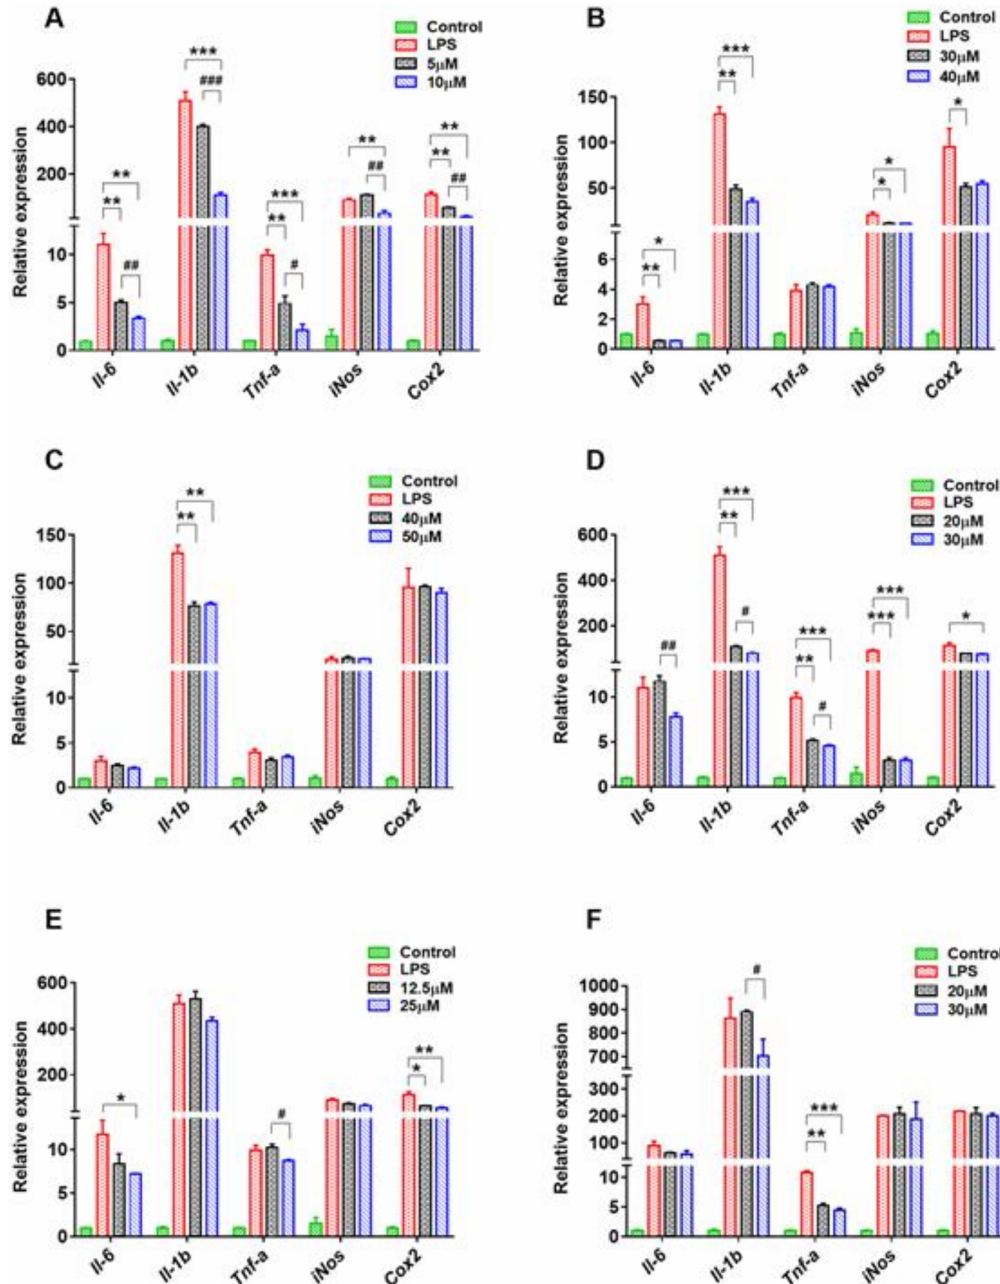
Figure 4. E ff ect of compounds 1 , 3 , 4 , and 6 – 8 ( A – F ) on the messenger RNA (mRNA) levels of interleukin-6 (IL-6), IL-1 β , tumor necrosis factor α (TNF- α ), inducible nitric oxide synthase (iNOS), and cyclooxygenase 2 (COX-2) in RAW264.7 cells stimulated by lipopolysaccharide (LPS). Data are presented as means ± standard error of the mean (SEM), n = 3; * p < 0.05, ** p < 0.01, *** p < 0.001, treatment vs. LPS model; # p < 0.05, ## p < 0.01, ### p < 0.001, high concentration vs. low